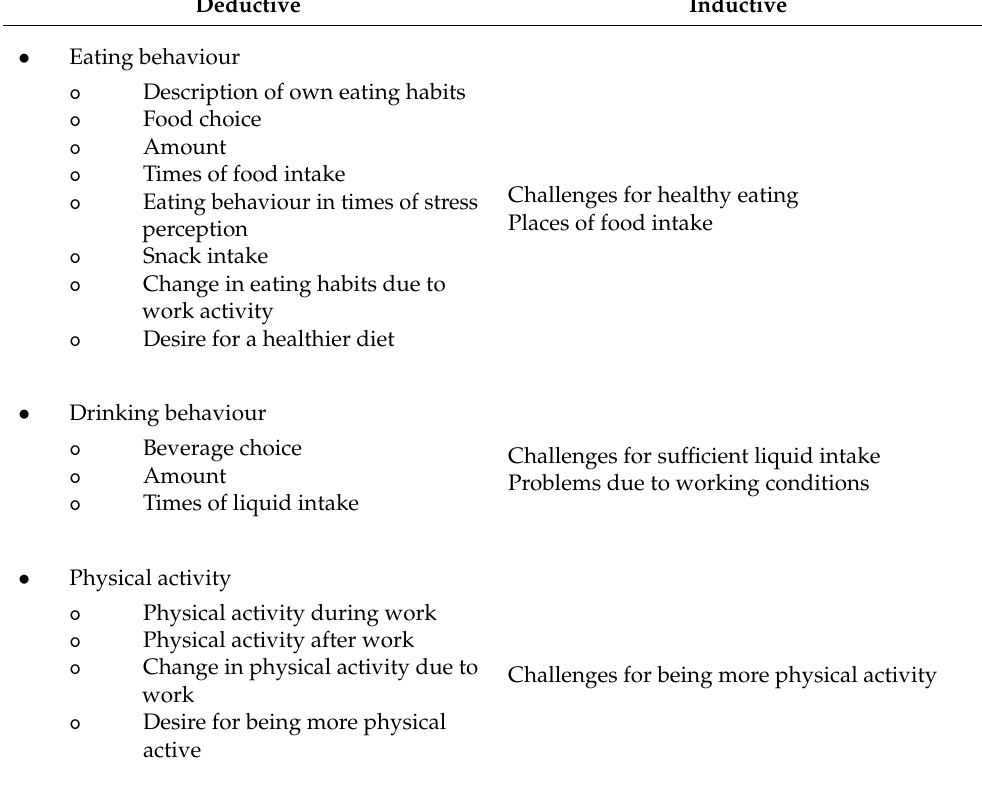
Table A2. Cont. Deductive